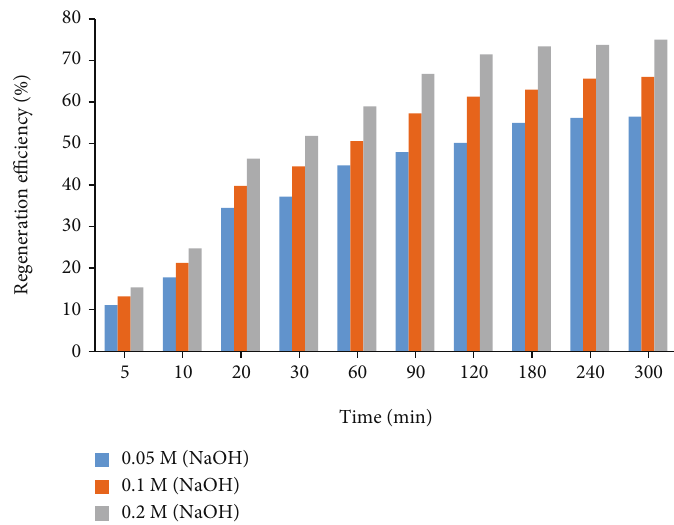
Figure 7: Reuse of regenerated adsorbent using di ff erent concentrations of